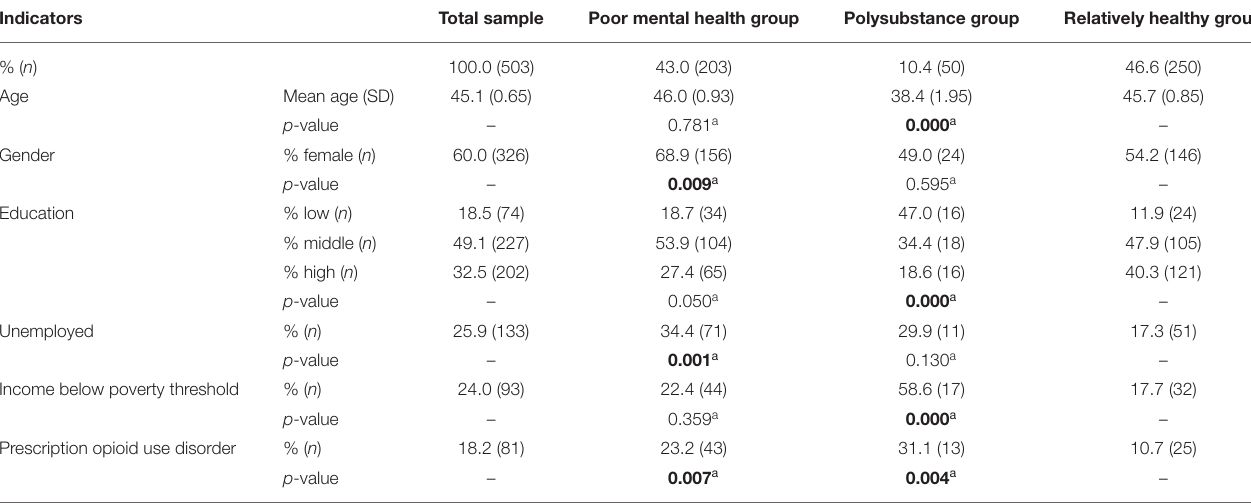
TABLE 3 | Baseline characteristics of the extracted